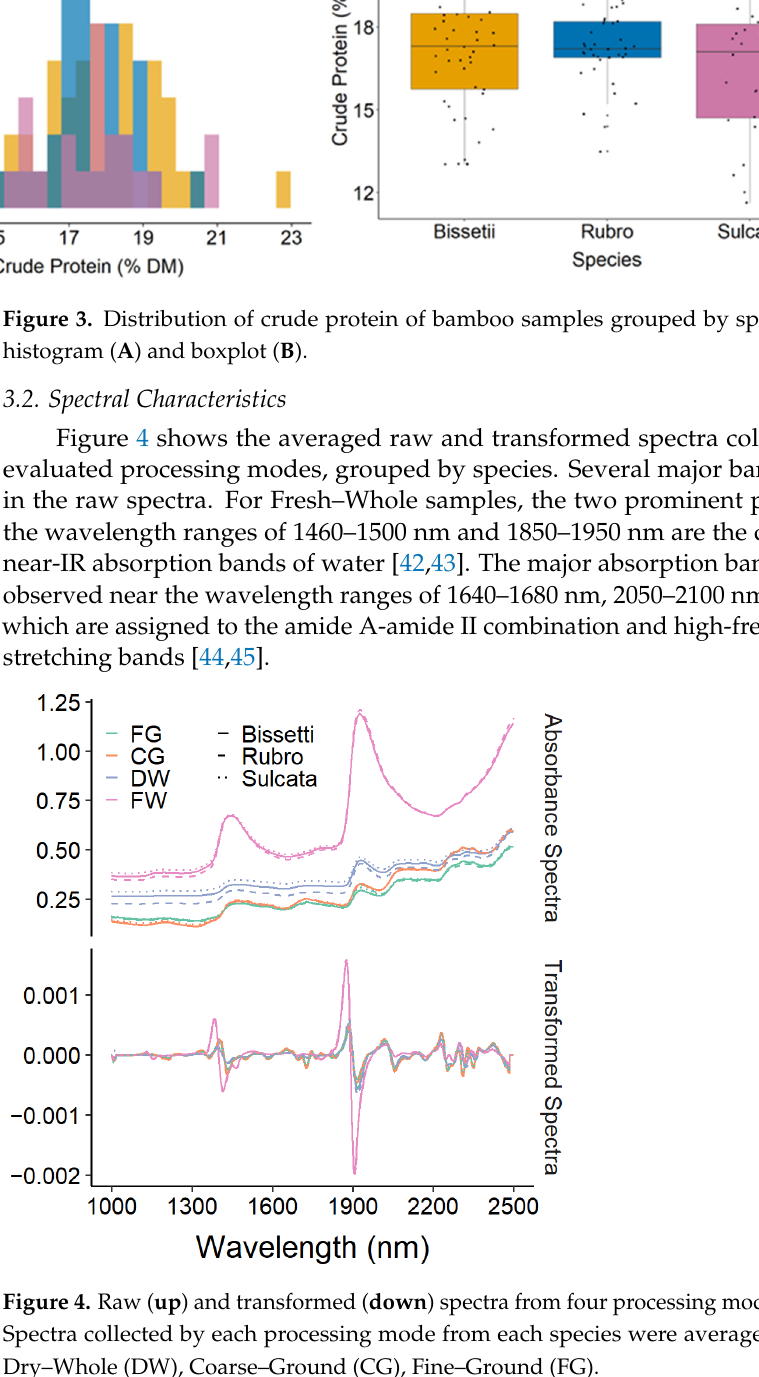
Figure 4. Raw ( up ) and transformed ( down ) spectra from four processing modes, grouped by spe- cies. Spectra collected by each processing mode from each species were averaged. Fresh–Whole (FW), Dry–Whole (DW), Coarse–Ground (CG), Fine–Ground (FG).